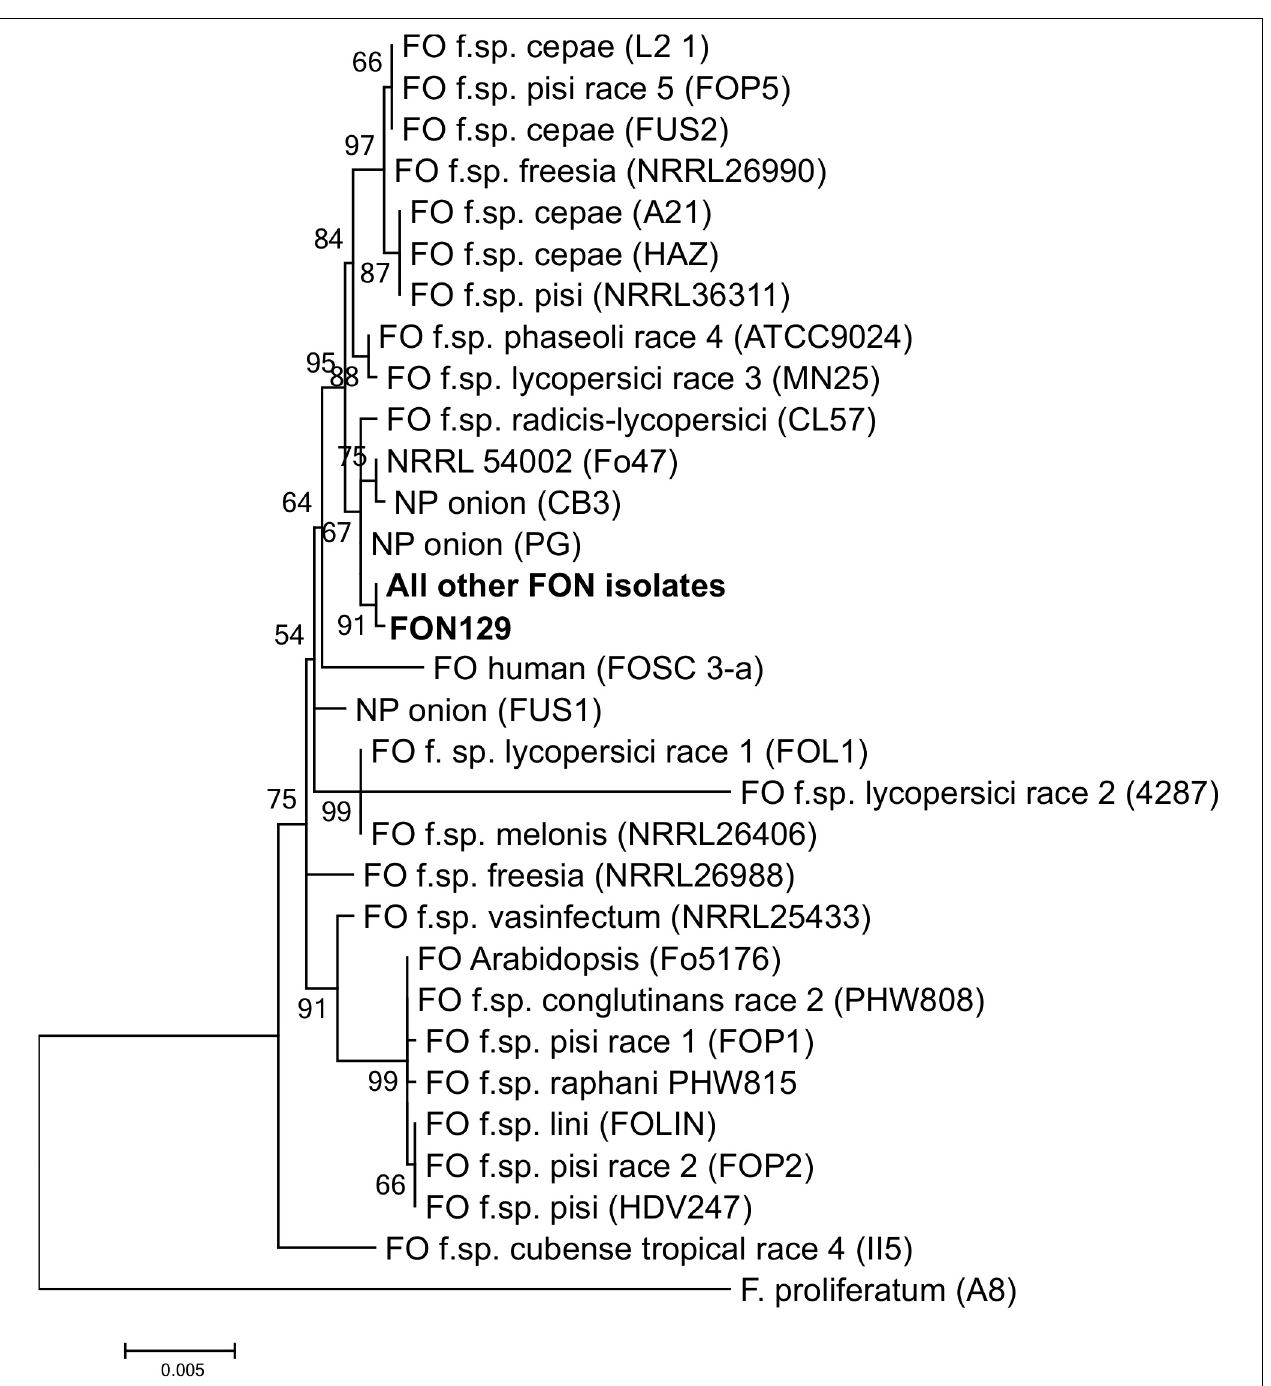
FIGURE 2 | Maximum likelihood tree showing relationships between Fusarium oxysporum isolates from Narcissus and other hosts based on a concatenated alignment of β -tubulin , translation elongation factor 1- α and RNA polymerase II second largest subunit . Numbers represent bootstrap (1000 replicates) and the scale bar indicates 0.005 substitutions per site. An isolate of F. proliferatum was used to root the tree. Additional sequences were obtained from Taylor et al. (2016). NP, non-pathogenic.